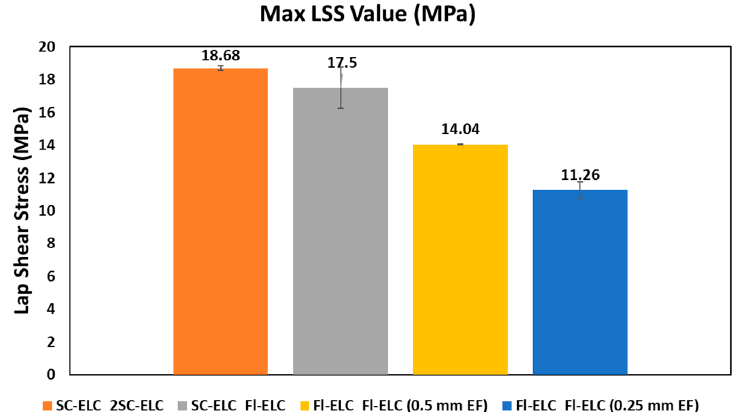
Figure 21. Comparison of LSS for the laminates welded with different ED configurations.